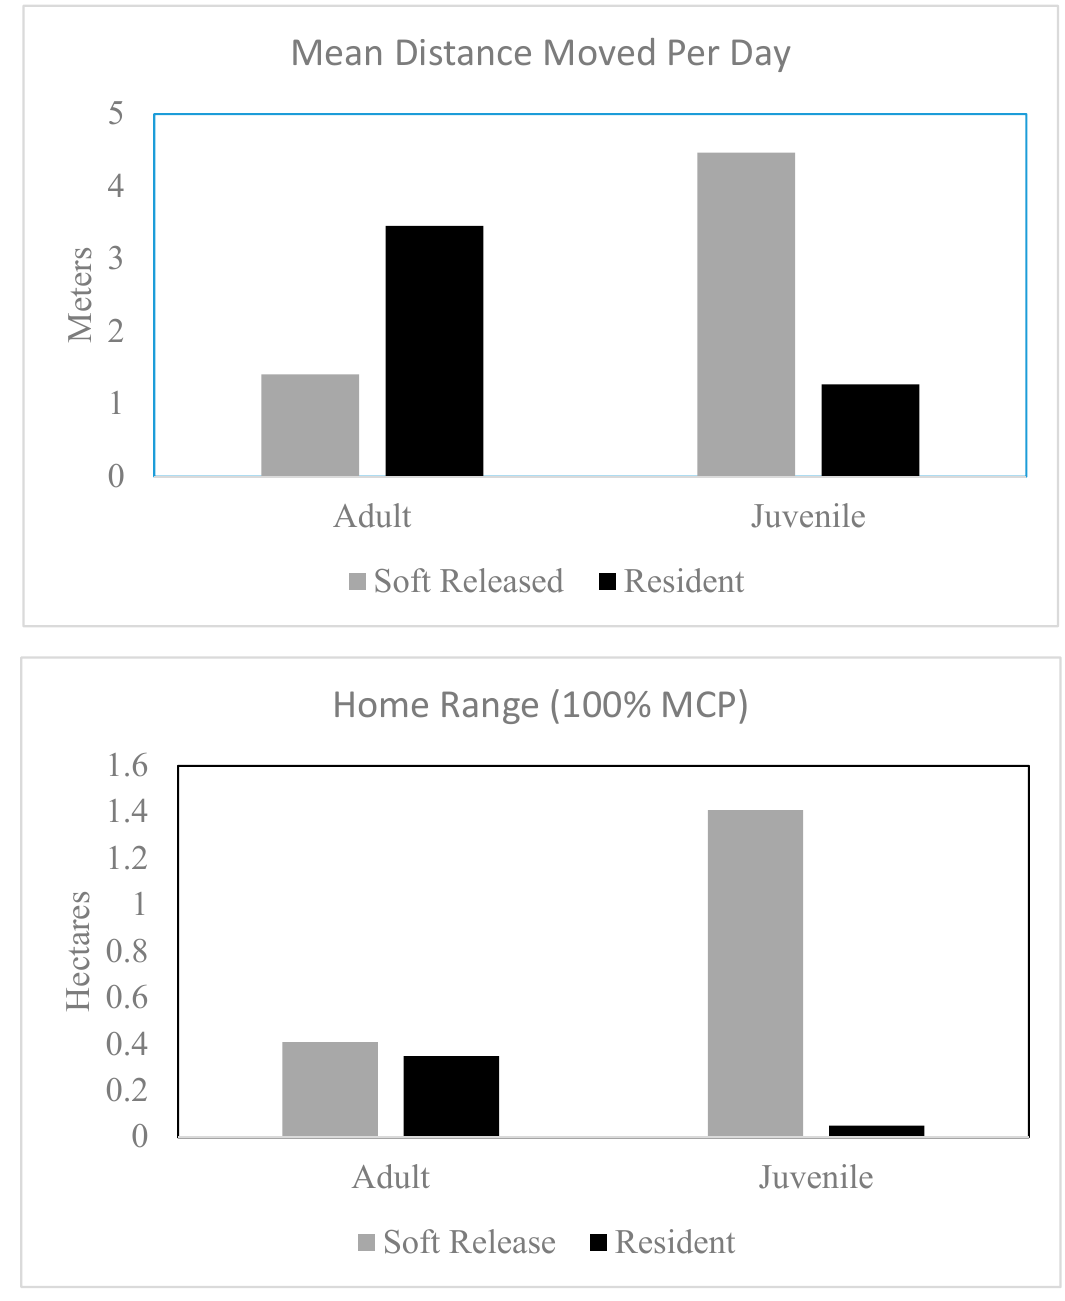
Figure 4. Average home range size (minimum convex polygons) and distance moved per day ( + 1 SD) of resident and translocated Texas horned lizards ( Phrynosoma cornutum ) on Tinker Air Force Base, OK.